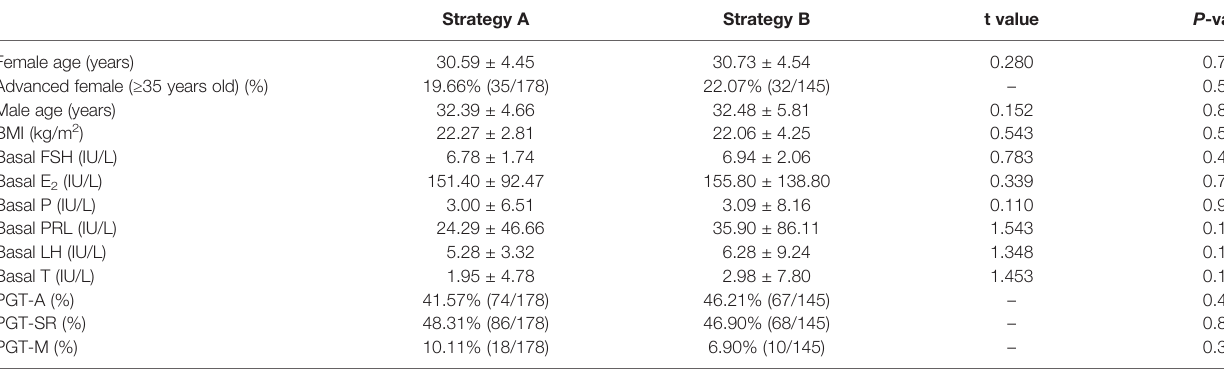
TABLE 1 | Baseline level of patients from the two biopsy strategies.